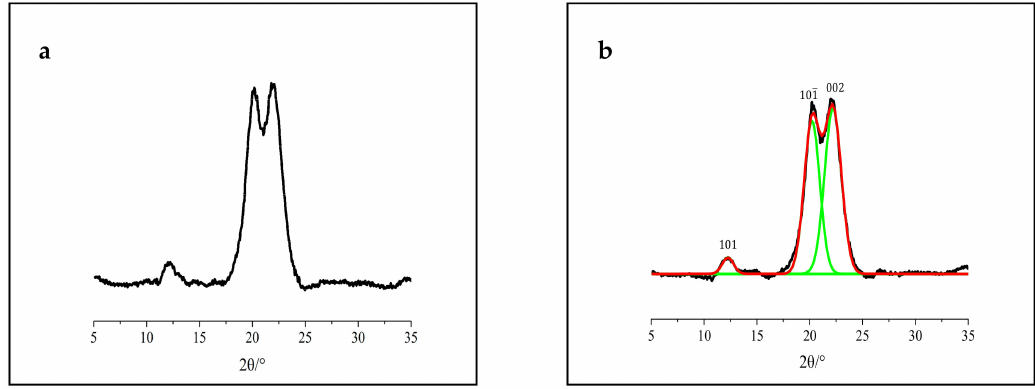
Figure 2. XRD patterns of tunicate cellulose: ( a ) original XRD pattern and ( b ) peak separation results.